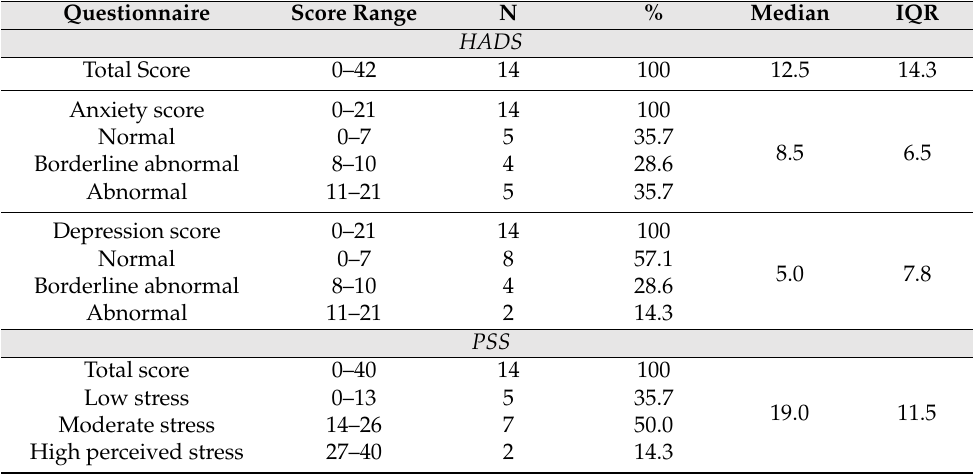
Table 2. Summary of psychosocial distress questionnaire scores.